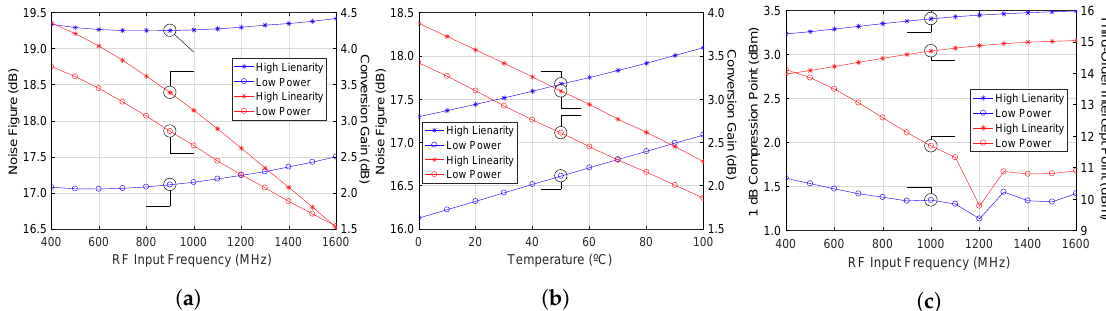
Figure 9. Measured response of the mixers: ( a ) noise figure and gain as a function of the RF input frequency, ( b ) noise figure and gain as a function of temperature and ( c ) 1dB compression point and third-order intercept point as a function of the RF input frequency. Table 1. Performance summary of the fabricated prototypes